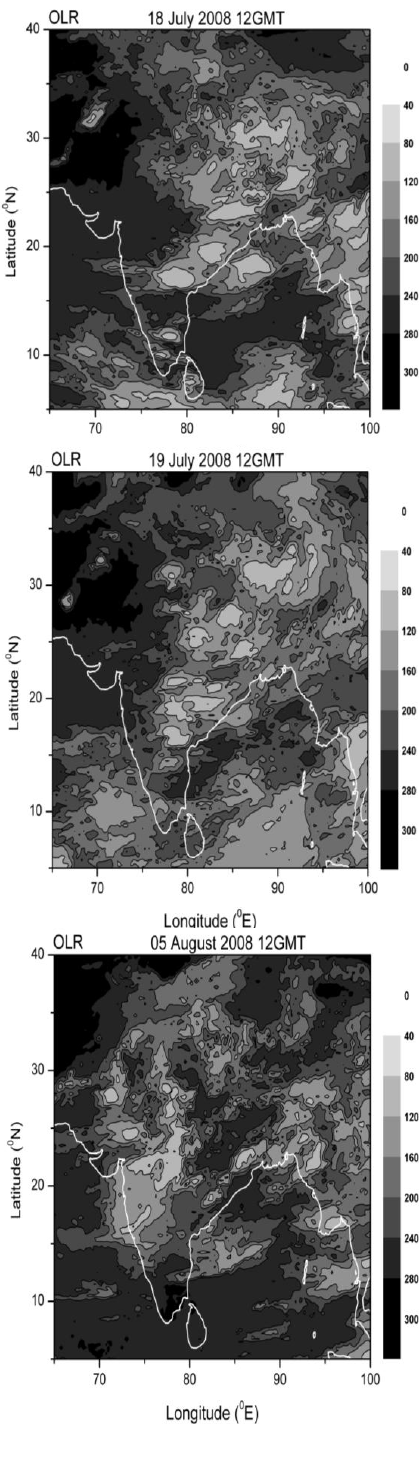
Fig. 4. Panels on left side show false color imagery (using Visible and Infrared channels) for three recent events from Kalpana-1 satellite. The temperatures noted on the map are identified using infrared (clean) and water Vapor (dirty) channels using separate tool. Some of the locations where the temperature from two channels is within ∼ 10K are marked with arrow. Geographic coordinates of these points are also mentioned. Right side panels show OLR contour maps, from Kalpana-1 satellite, corresponding to imagery shown on left side. OLR with values ≤ 160Wm − 2 are shown by light grey